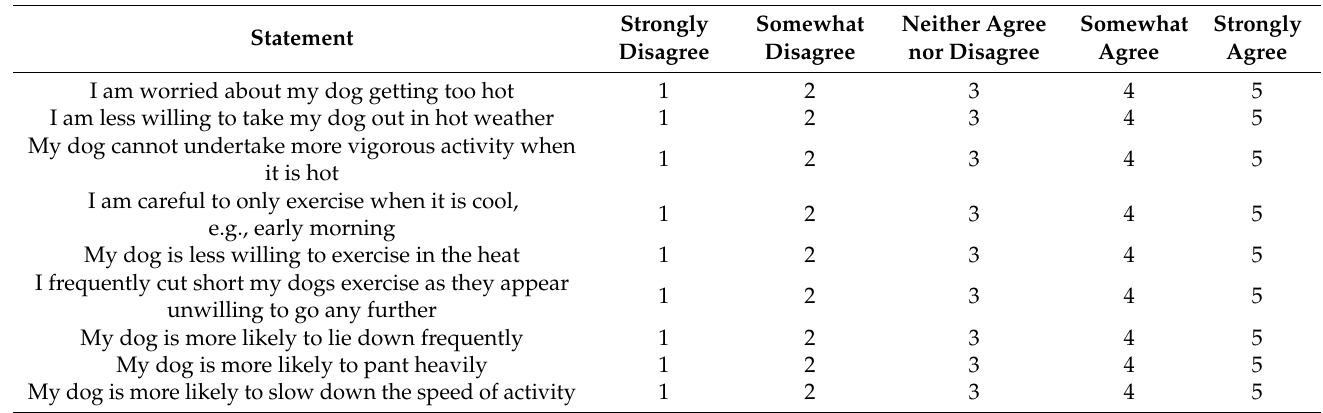
Table 2. Survey questions used to generate a summer canine activity